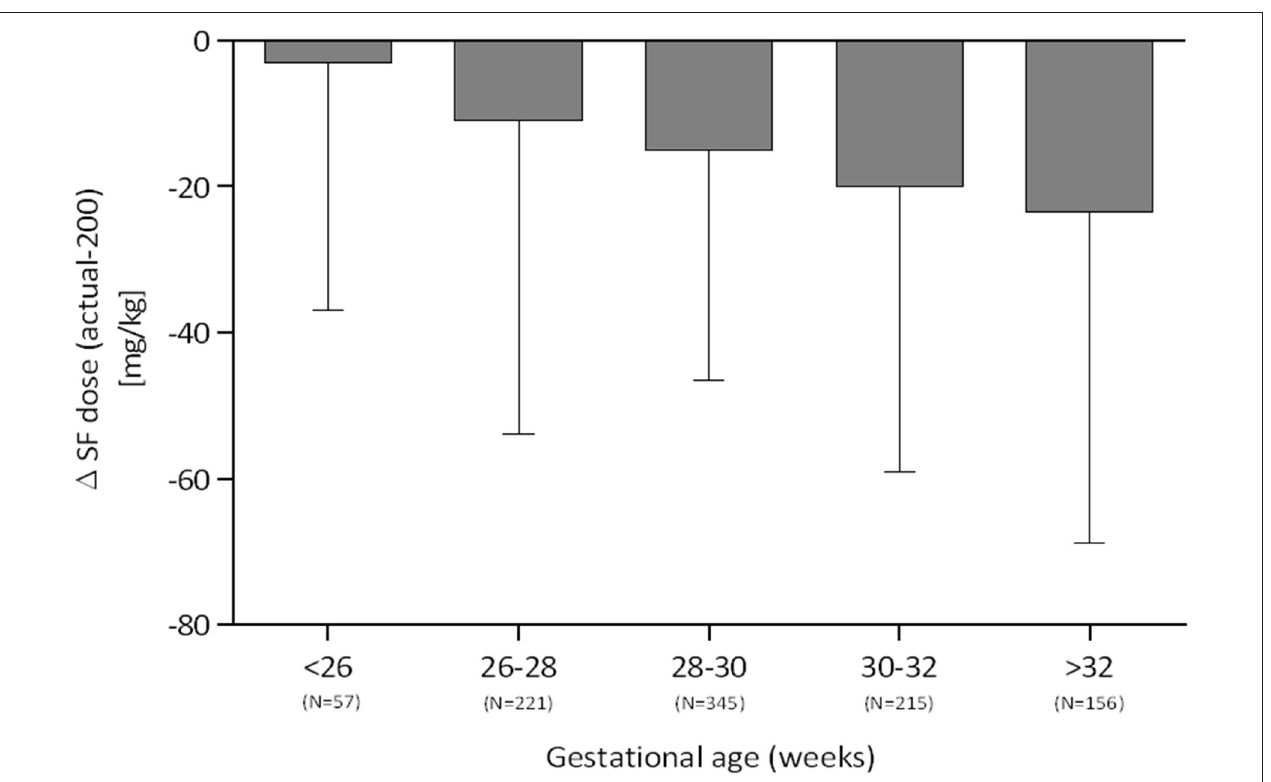
FIGURE 2 | Deviation from the recommended dose of 200 mg/kg surfactant stratified by gestational age (median, IQR).